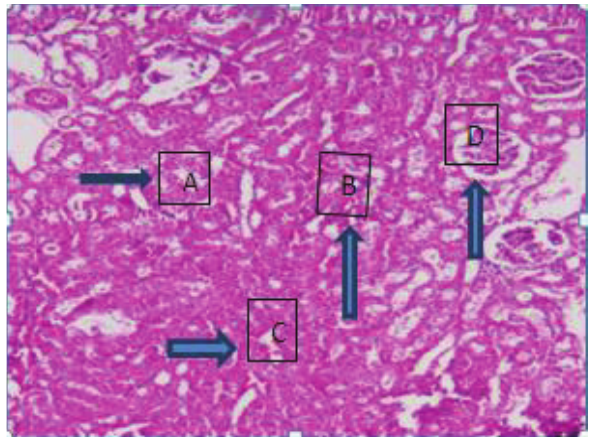
Fig-1: Showing normal histology of kidney in group 1 (negative control)